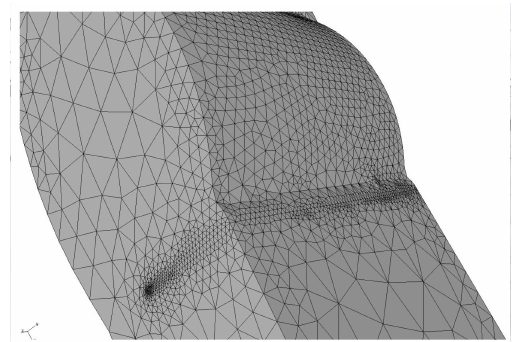
Figure 11. Appearance of the crack for the model with 3 mm of weld